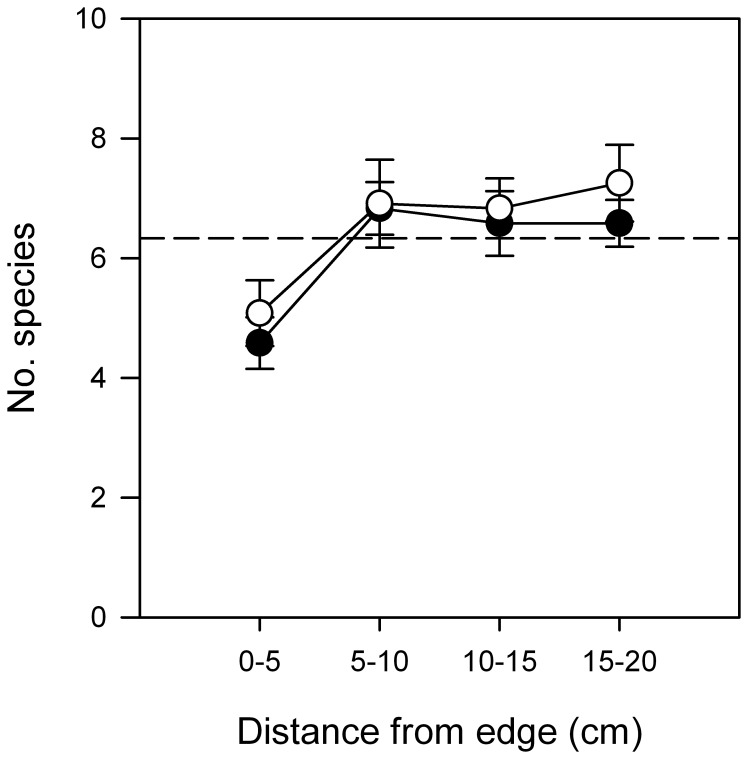
Effects of edges on numbers of species.Mean (±SE) numbers of species as a function of distance from edge of habitat (0–5, 5–10, 10–15 and 15–20 cm). For clarity in presenting the effect of distance from edge of habitat, the numbers of species were averaged across 2 habitat types (Sparse and Dense) and 3 replicate experimental landscapes in each site (1: •; 2: ○). Letters indicate means that are significantly different (SNK at P <0.05).